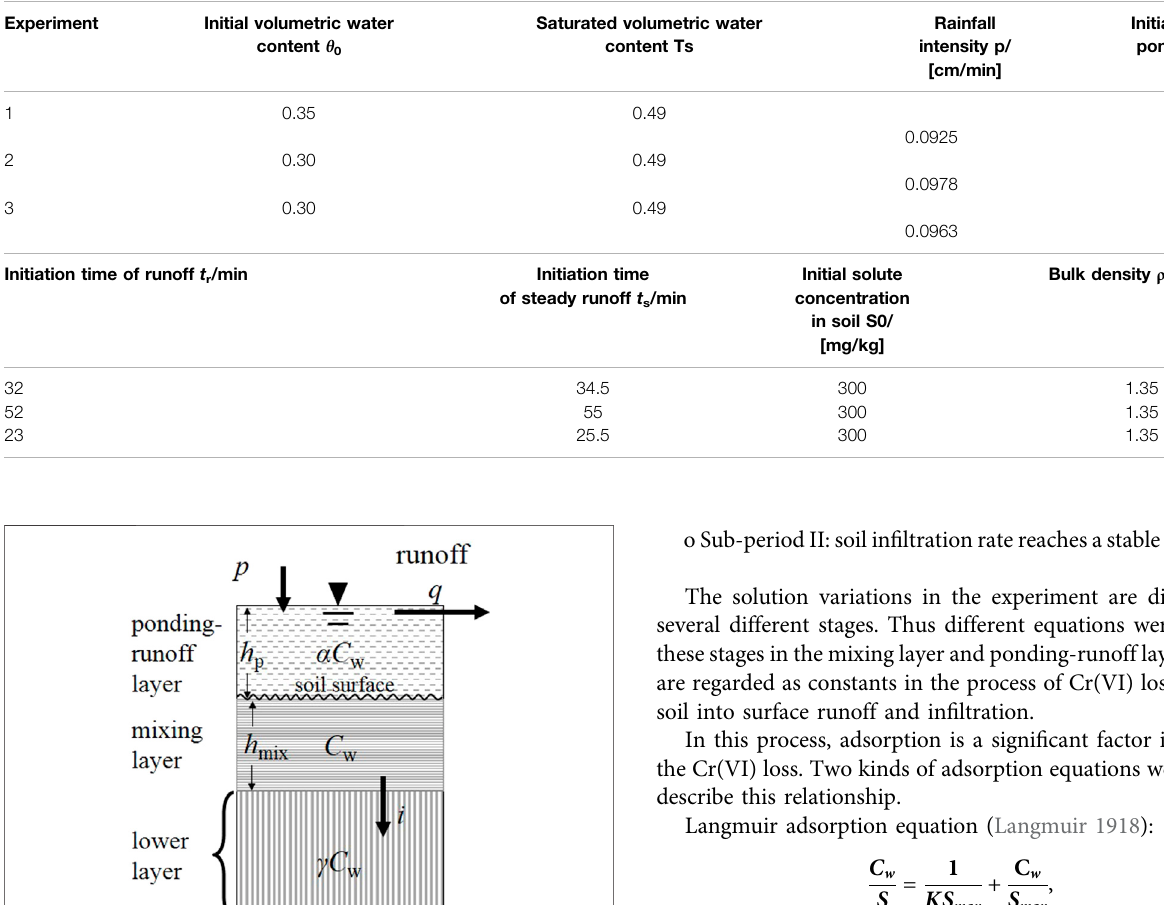
TABLE 1 | Experimental and simulation parameters used in this test.